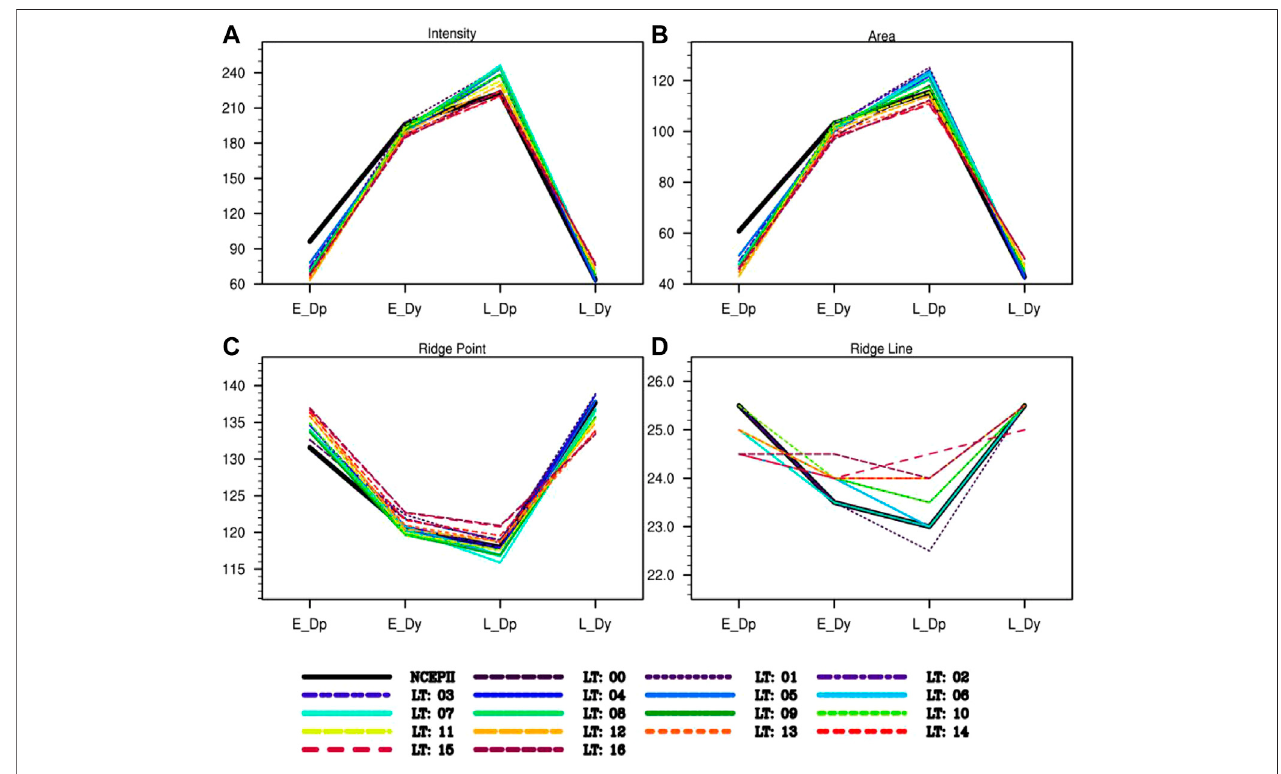
FIGURE6| ForecastsoftheWNPSHindicesinNCEP-GEFSfor (A) Intensity, (B) Area, (C) ridgepointand (D) ridgelineduringthedifferentphasesofENSO(E_Dp, E_Dy, L_Dp and L_Dy represent the El Niño developing, El Niño decaying, La Niña developing, and La Niña decaying summers, respectively) at the different lead time (0 – 16